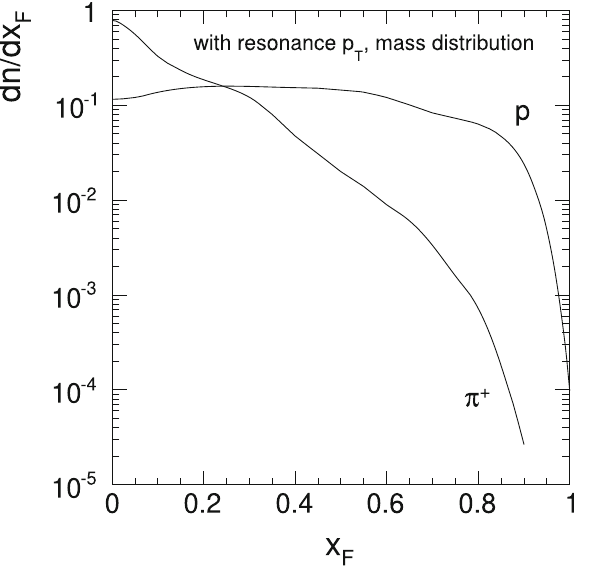
Fig. 157 R (cid:4) p as a function of x F for the different decay configura- T (cid:5) tions Sects.